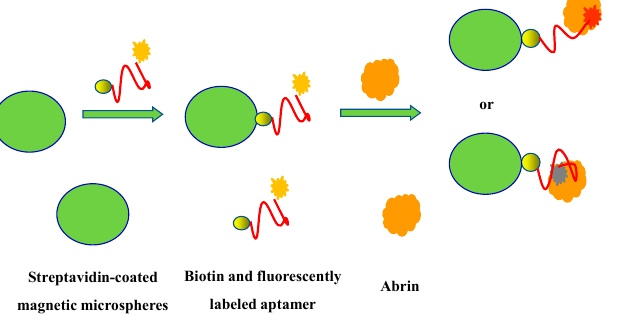
Figure 1. The principle of abrin detection based on the interaction between target molecules and fluorescently labeled aptamers on magnetic microspheres.